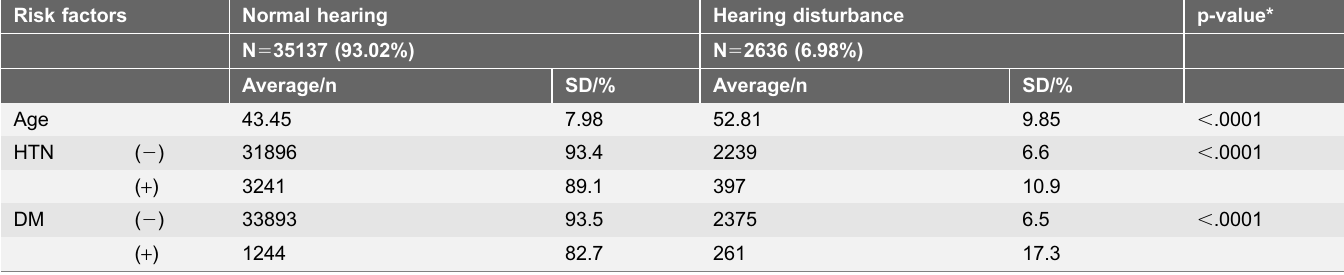
Table 2. Baseline characteristics of hearing disturbance and normal groups.